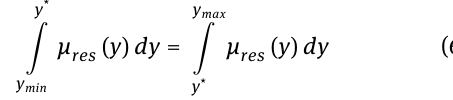
Two methods of defuzzification were eventually in- cluded in the defuzzification block, that is, the centre of gravity method and bisector area method. For the centre of gravity method the sharp output value is obtained on